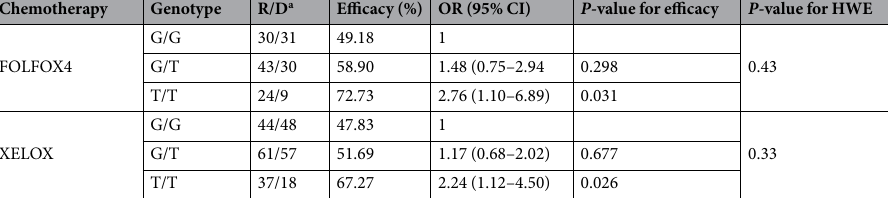
Table 1. The association of rs3742106 with the response of chemotherapy. a R, the number of patients achieving partial response and complete response; D, the number of patients with stable disease and progressive